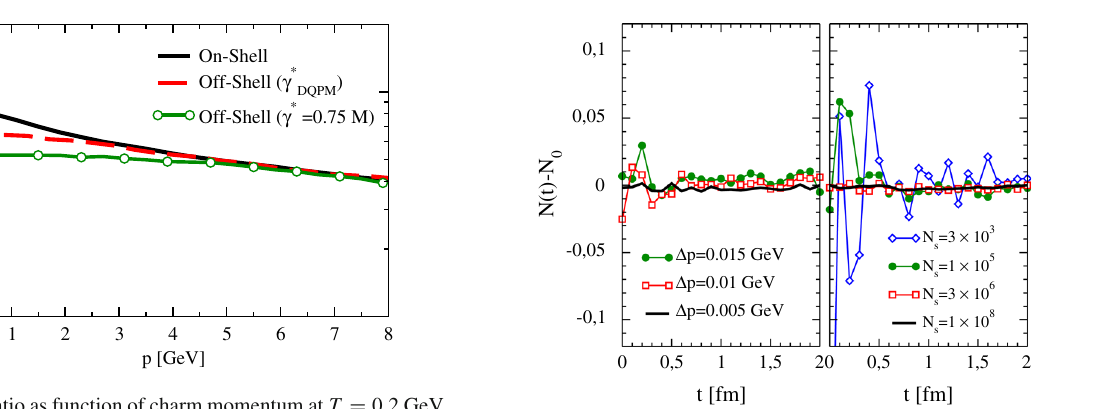
Fig. 9 A ( p )/(cid:7) ratio as function of charm momentum at T = 0 . 2 GeV for on shell (black solid line) and off-shell γ ∗ (red dashed line) DQPM Fig. 10 N ( t ) − N 0 as a function of time. Left panel different lines and γ ∗ = 0 . 75 M (open green circles) are for different momentum discretization with a fixed number of MC sampling to N s = 10 8 while in the right panel the different lines refers to the different MC sampling used for Δ P = 0 . 005